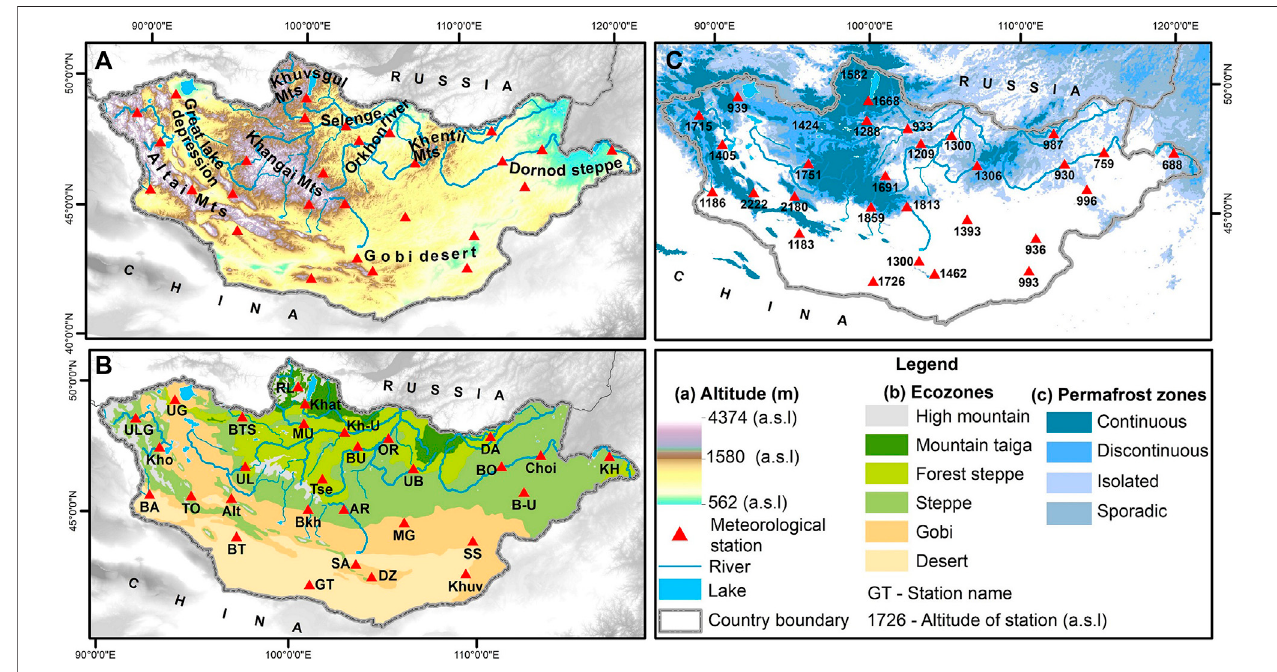
FIGURE 1 | (A) Digital elevation map depicted from the Shuttle Radar Topography Mission (SRTM-DEM) with a 30 m resolution. (B) Ecozones of Mongolia based on Doljin and Yembuu (2021), (C) Permafrost distribution around Mongolia based on Obu et al. (2019).